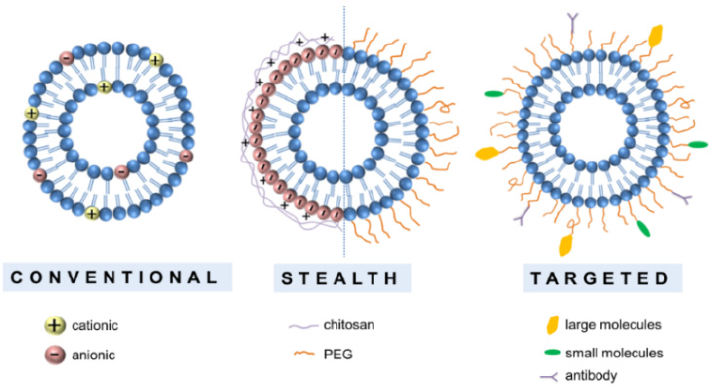
Figure 2. Main types of liposomes.